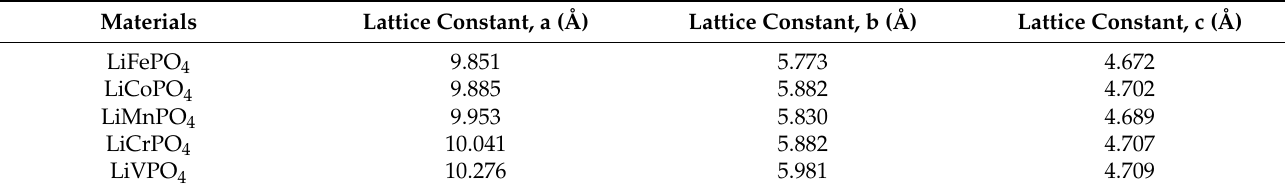
Table 1. The Lattice Constants of Different Olivine LiMPO 4